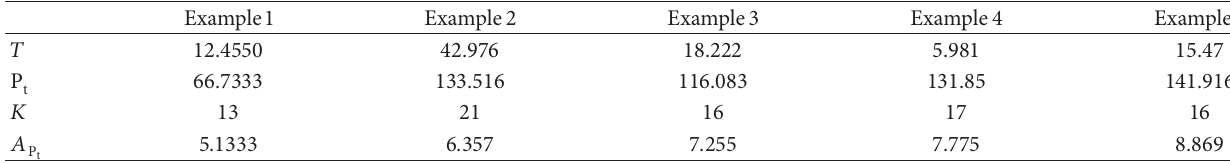
and GA . TSP sequencing